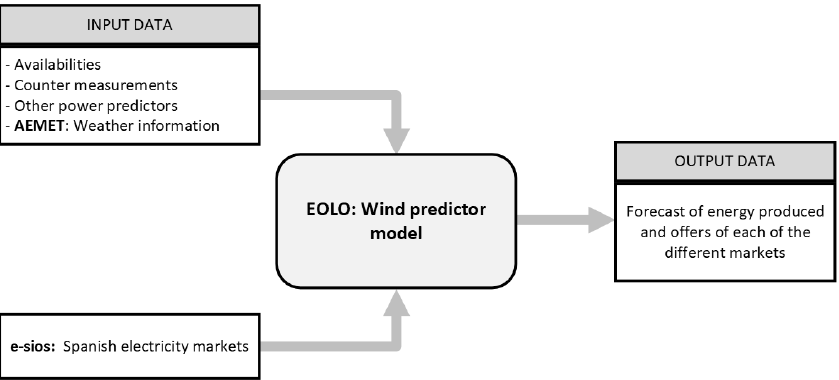
Figure 2. EOLO input and output